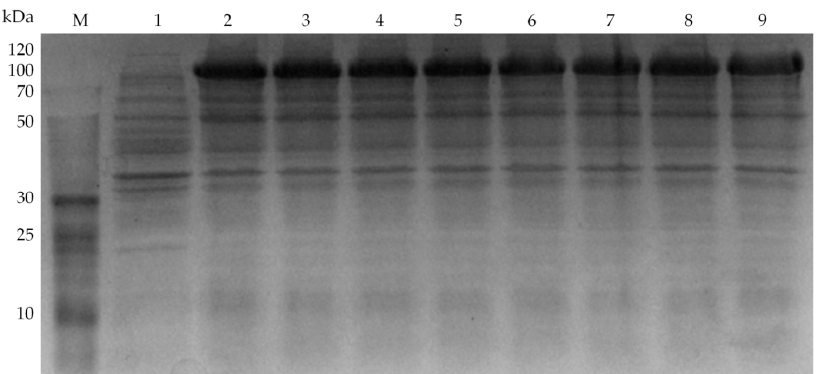
Figure 2. SDS-PAGE analysis of eight fusion proteins with different organizations. Lane M, protein marker; lane 1, no induction of the fusion enzyme as the control; lane 2, Vs HGB-GSG- So GOX-GSG- Hp CAT; lane 3, Vs HGB-GSG- So GOX-GGGGS- Hp CAT; lane 4, Vs HGB-GGGGS- So GOX-GSG- Hp CAT; lane 5, Vs HGB-GGGGS- So GOX-GGGGS- Hp CAT; lane 6, Hp CAT-GSG- So GOX-GSG- Vs HGB; lane 7, Hp CAT-GSG- So GOX-GGGGS- Vs HGB; lane 8, Hp CAT-GGGGS- So GOX-GSG- Vs HGB; lane 9, Hp